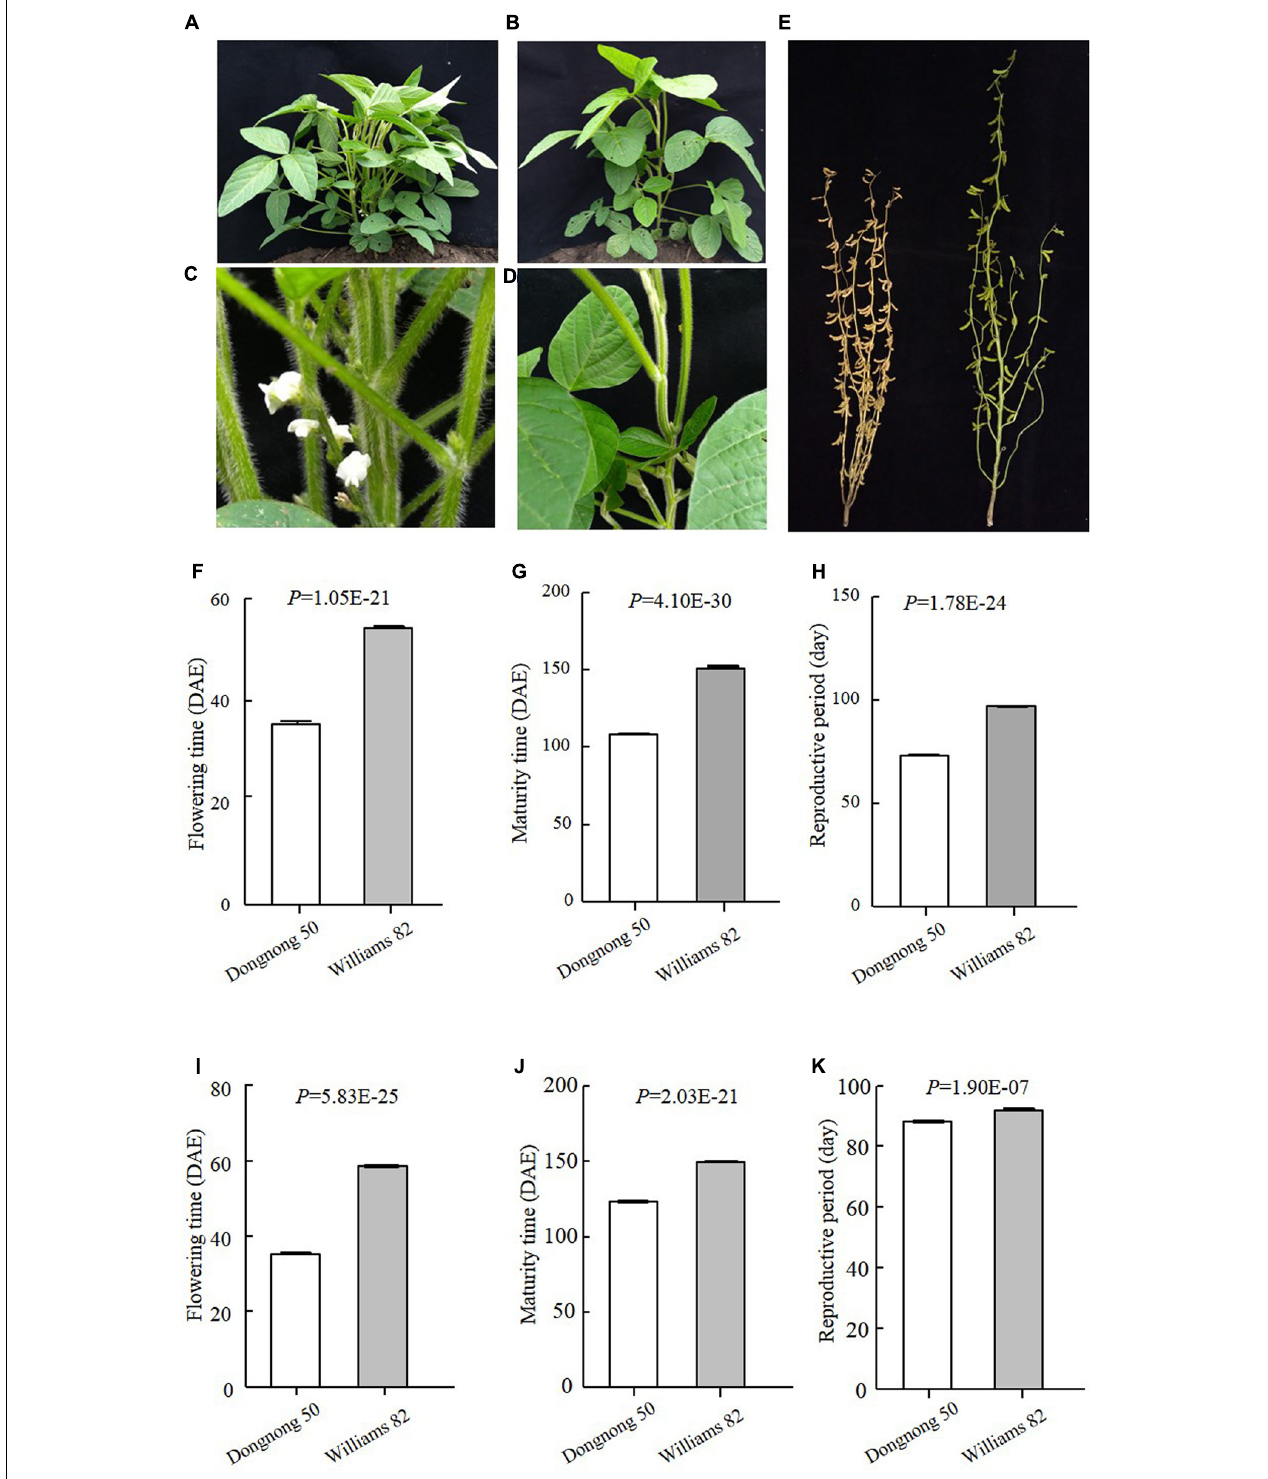
FIGURE 2 | Phenotypes of the parents of DW population. (A–D) Plants when Dongnong 50 had flowered, while Williams 82 was still in the vegetative growth stage. ( A,C Dongnong 50; B,D Williams 82). (E) Plants when Dongnong 50 has already fully matured, while Williams 82 was still in the seed filling growth stage. Left is Dongnong 50 and right is Williams 82. (F–H) Phenotypes data of the parents in 2016 Harbin. (I–K) Phenotypes of the Parents in 2017, Harbin. DAE, day after emergence.